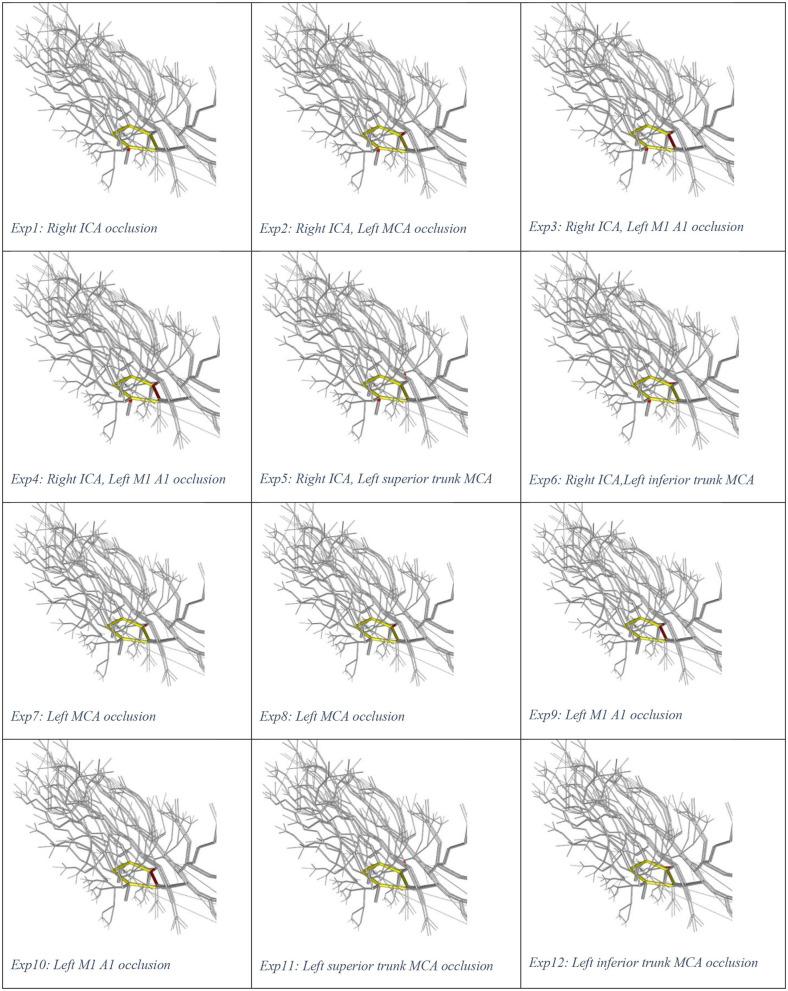
Visual representations of Experiments 1–12.